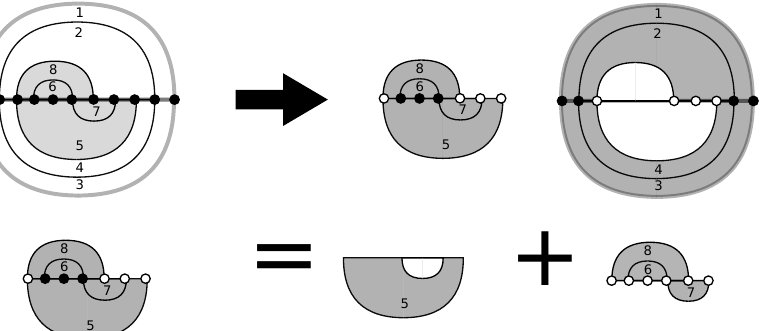
Figure 2. Top: a bi-structure decomposed into a distinguished sub-structure and its complement. The vertices contained in both (white) control the complexity of the dynamic programming (DP) routine in [2]. Bottom: the recursive step of the DP routine. Note that the recursion changes the set of white vertices by removing some and adding